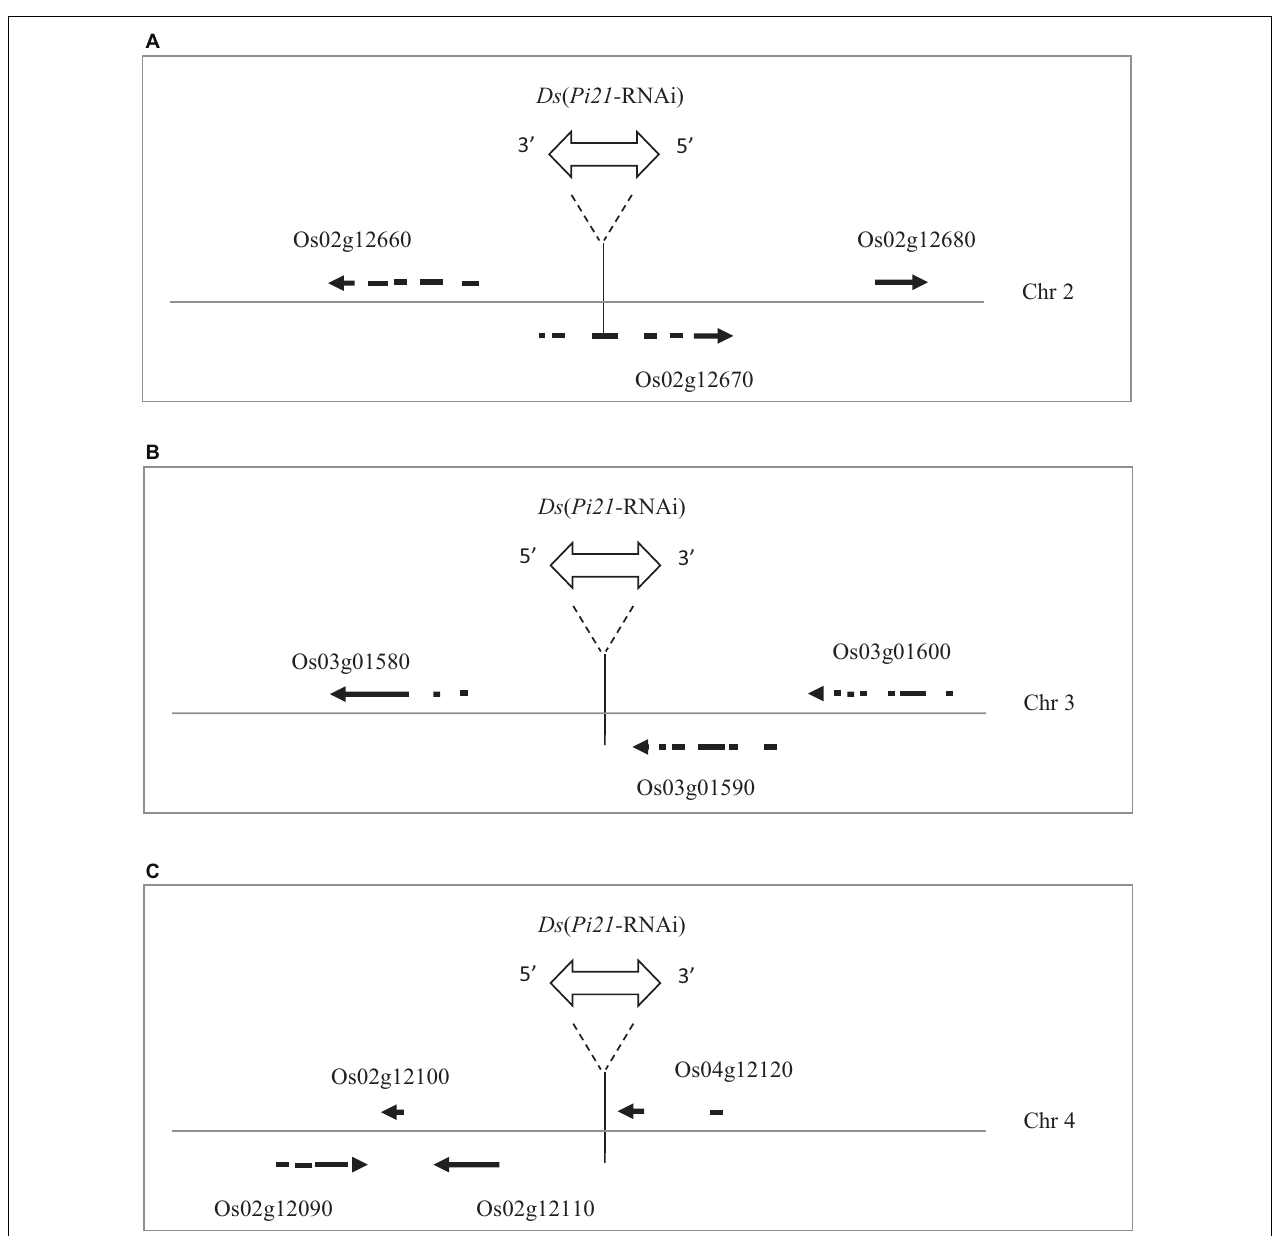
FIGURE 6 | Ds ( Pi21- RNAi) reintegration sites in three marker-free transgenic rice. (A) The Ds insertion (Chr02:6618501) in the 14YD270-1 rice line disrupted the coding region (CDS) of rice gene Os02g12670. (B) The Ds insertion (Chr03:369962) in the 14YD273-2 line is 3579 bp upstream from the Os03g01580 CDS and 494 bp downstream of the Os03g01590 CDS. (C) The Ds insertion (Chr04:6664522) in the 14YD271-3 line is 2864 bp upstream from the Os04g12110 CDS and 205 bp downstream of the Os04g12120 CDS.